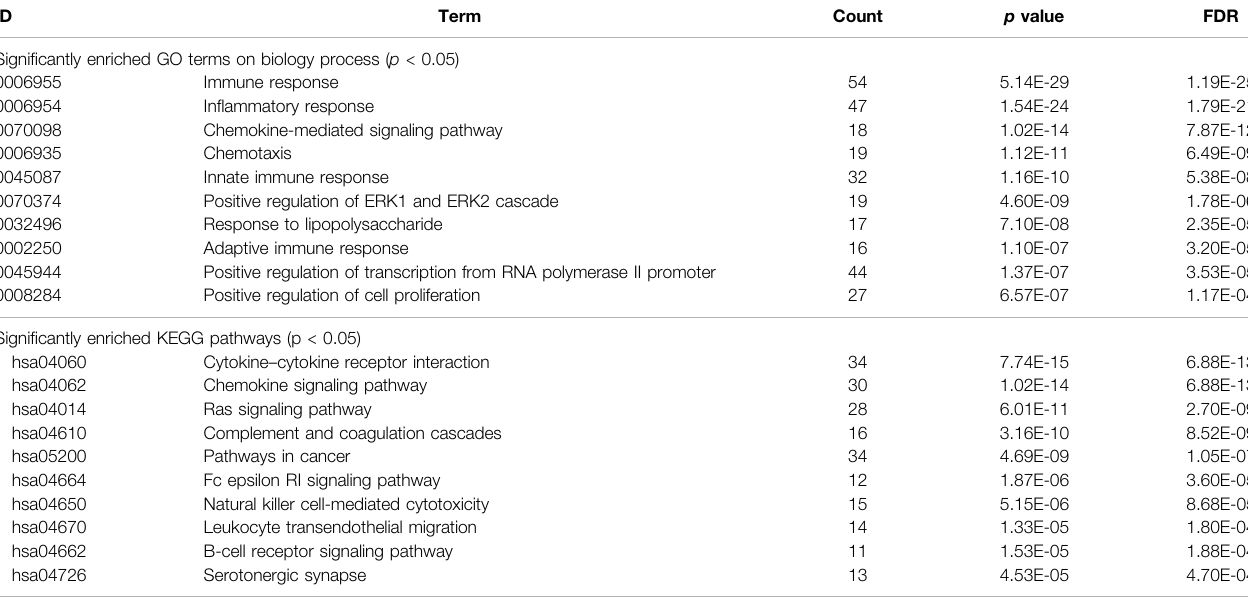
TABLE 1 | Top ten GO and KEGG analyses on 326